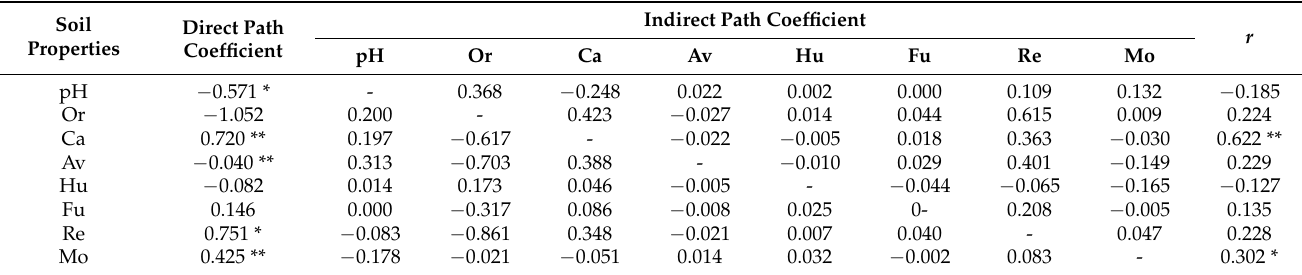
Table 3. Path analysis between soil properties and